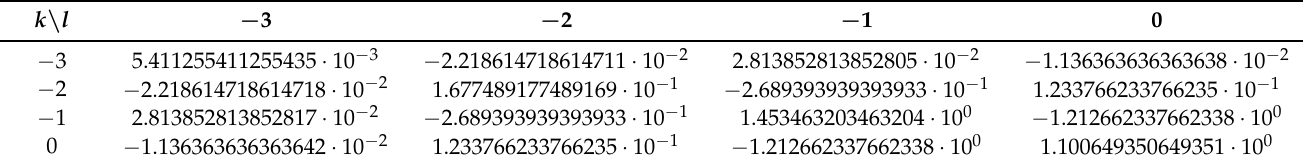
Table 4. The values of the integrals I k , l ( D x Φ I